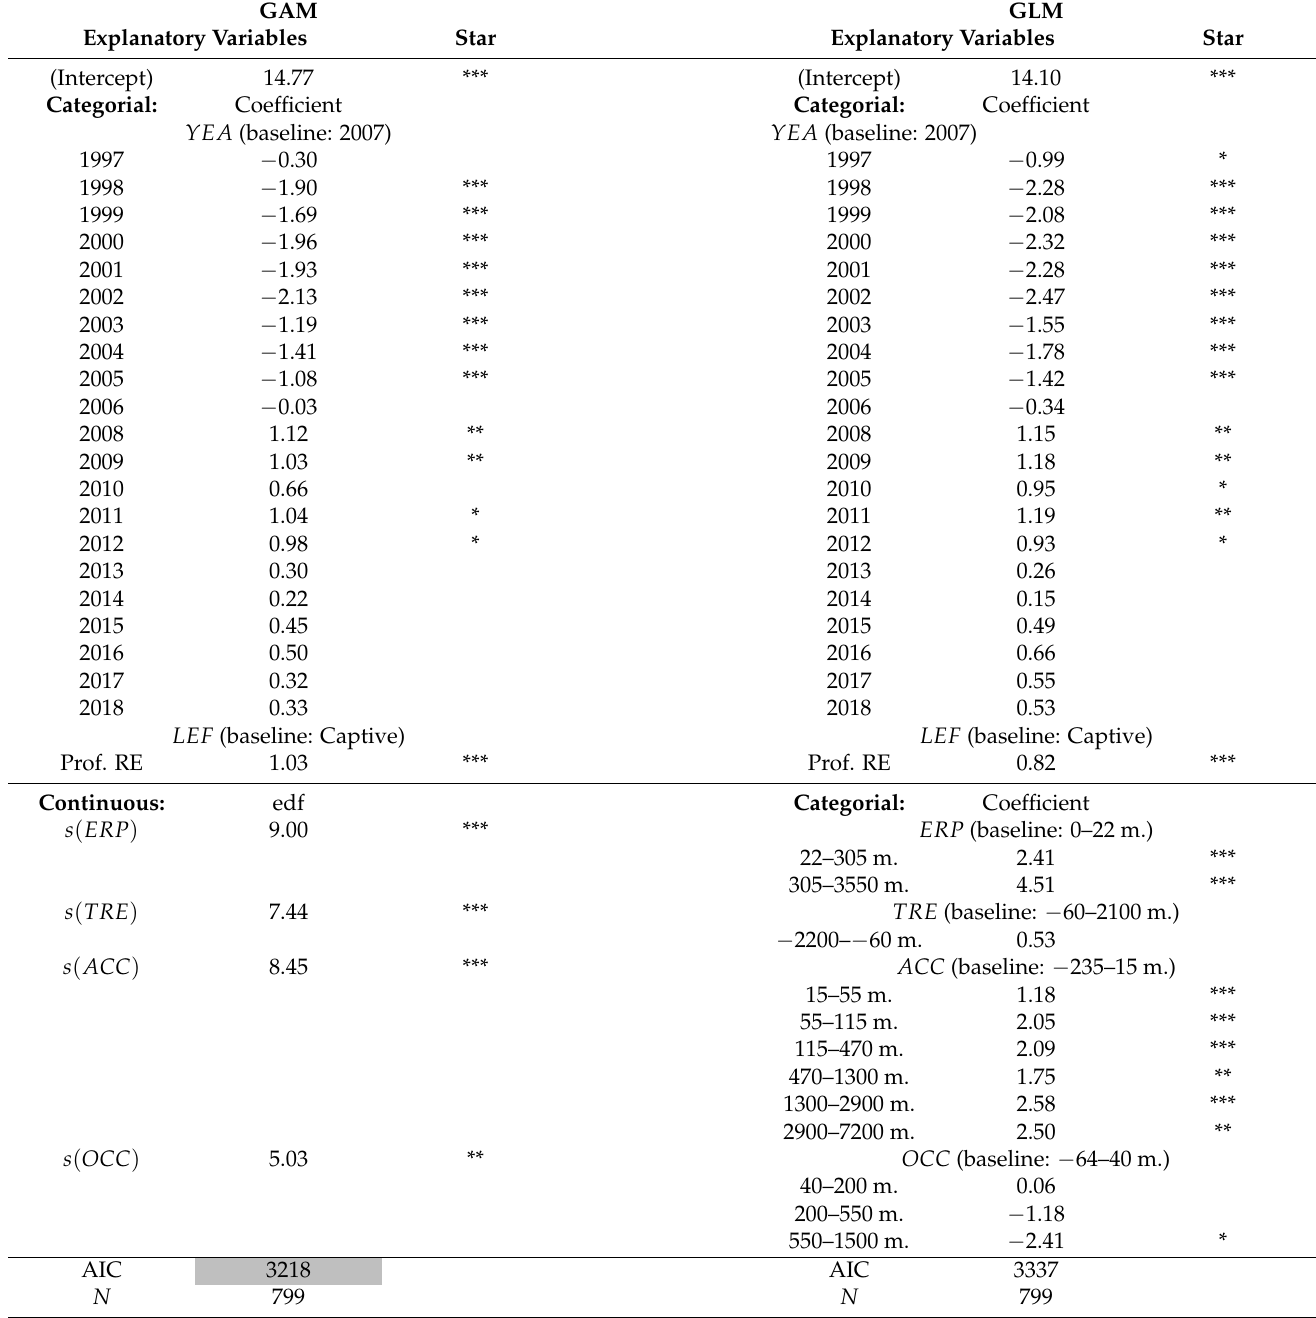
Table 7. Output of the GAM and GLM for reinsurance undertakings.